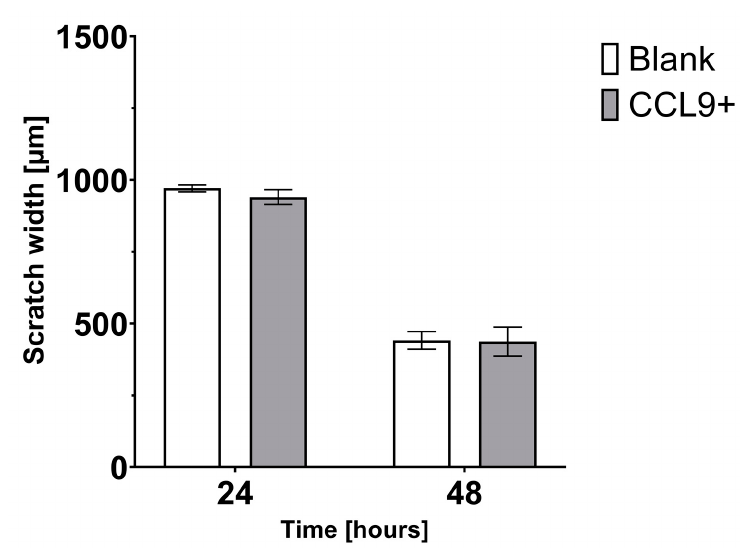
Figure 5. Scratch assay evaluating the ability of the modified CT26 cells to migrate.